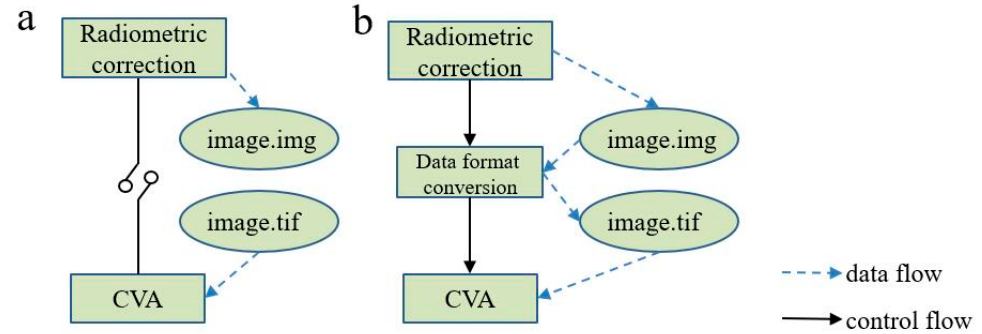
Figure 12. Actual implementation of the two service chains: ( a ) executed failed; ( b ) executed successfully.